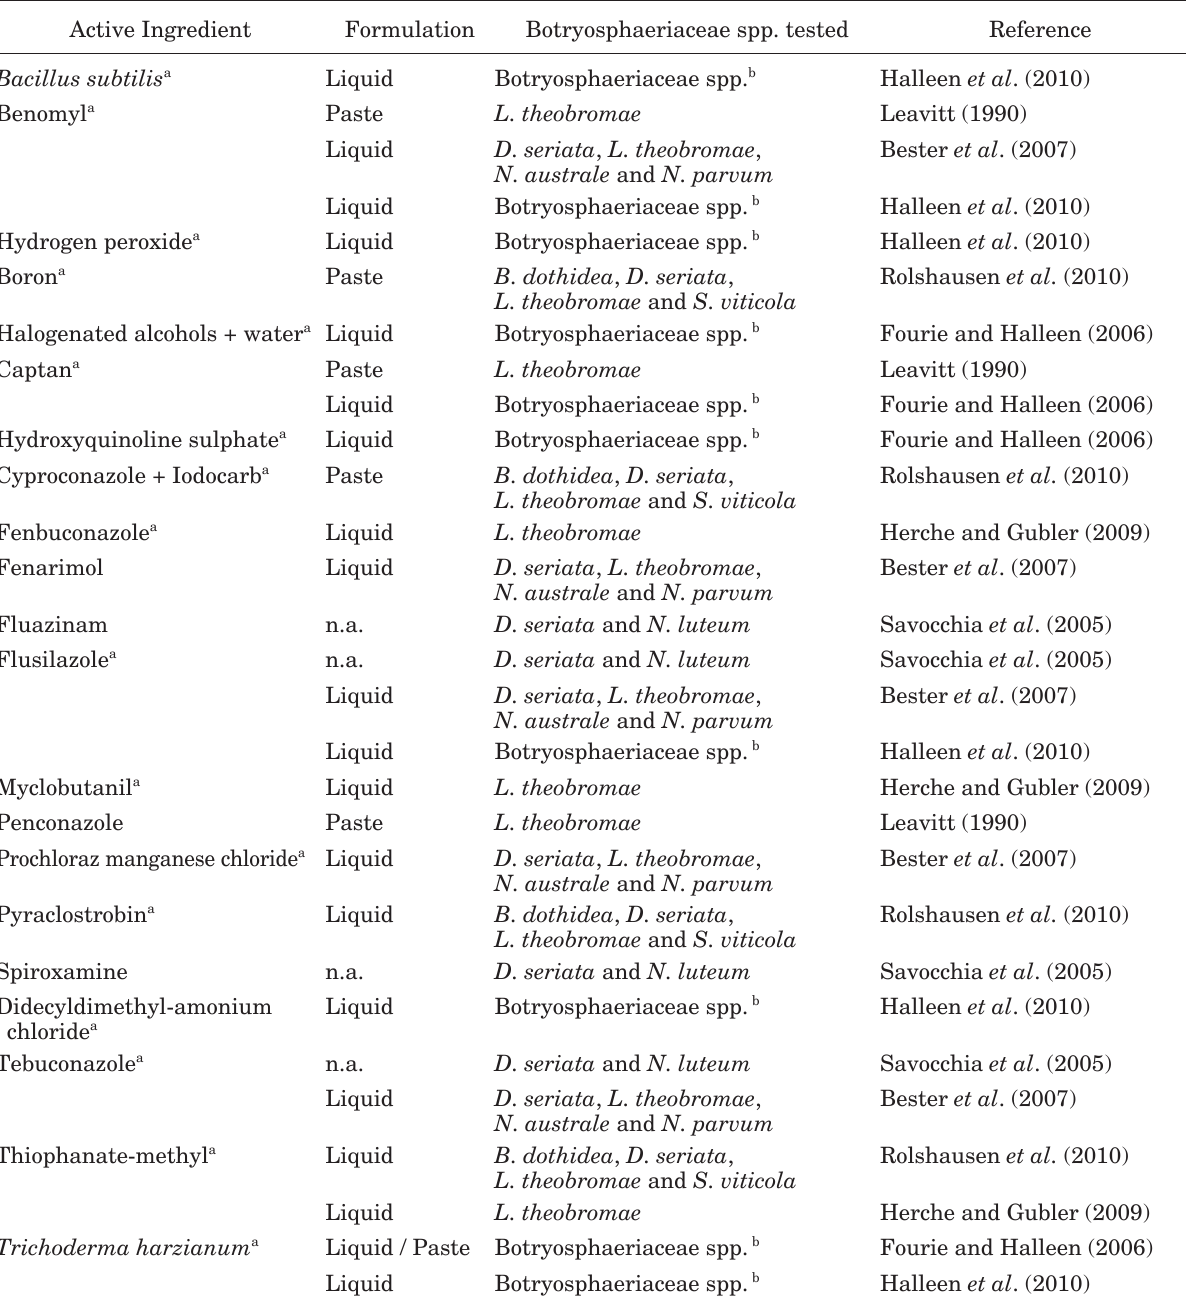
Table 3. Biological and chemical products tested against Botryosphaeriaceae species as grapevine trunk disease pa- thogens. Only active ingredients that have given positive effects in controlling botryosphaeriaceous taxa are